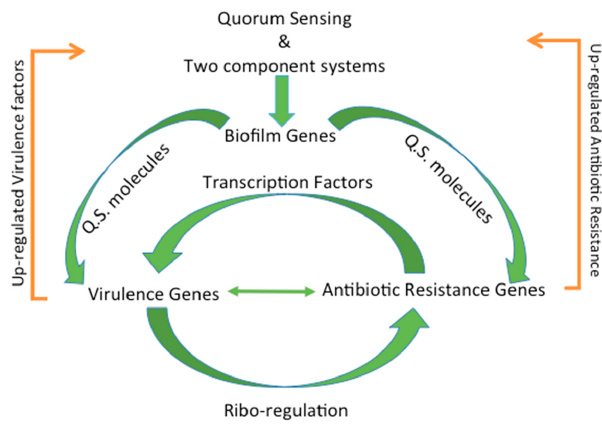
Figure 4. Common regulatory mechanisms act as a connection between virulence and antibiotic resistance. Quorum sensing and two component systems upregulate biofilm genes, which in turn upregulate quorum sensing molecules that in turn influence virulence and antibiotic resistance genes. Up-regulated virulence and antibiotic resistance genes serve to upregulate quorum sensing and two component systems and complete the